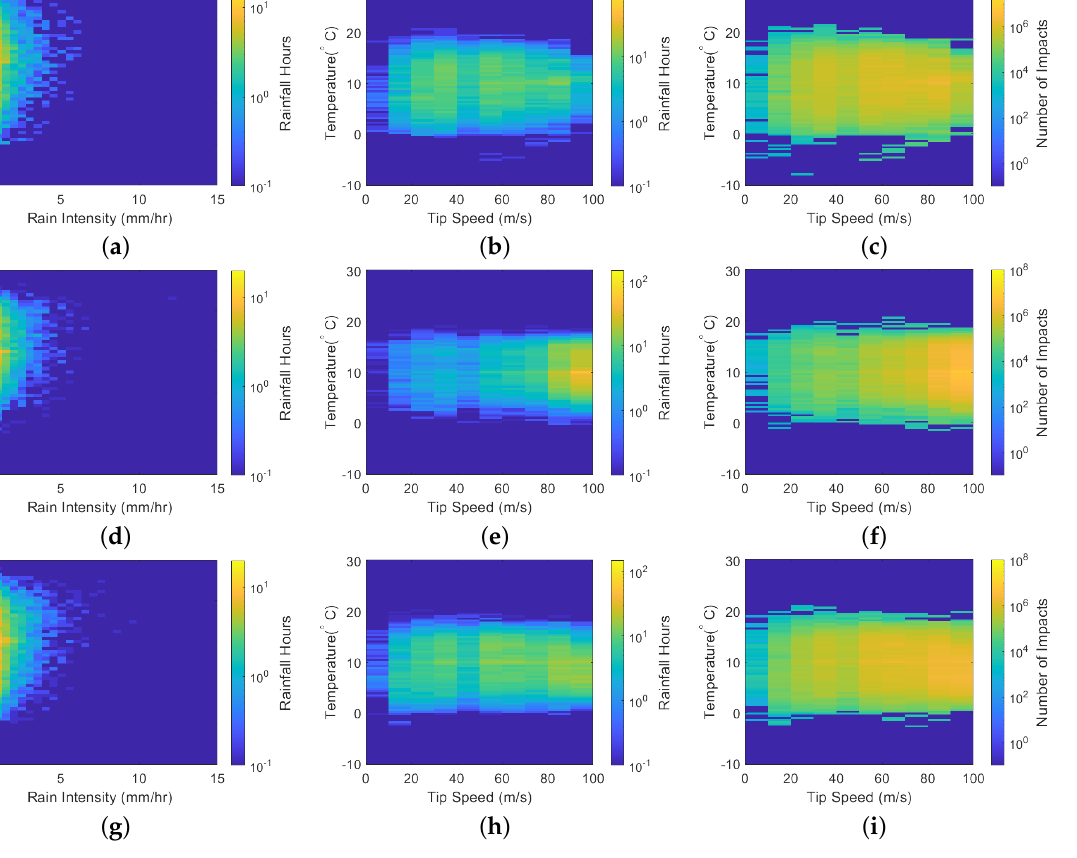
Figure 16. Average annual temperature/rainfall ( a – c ), temperature/rainfall/tip speed ( d – f ) and temperature/ n A /tip speed ( g – i ) distributions for stations A, MA and N,